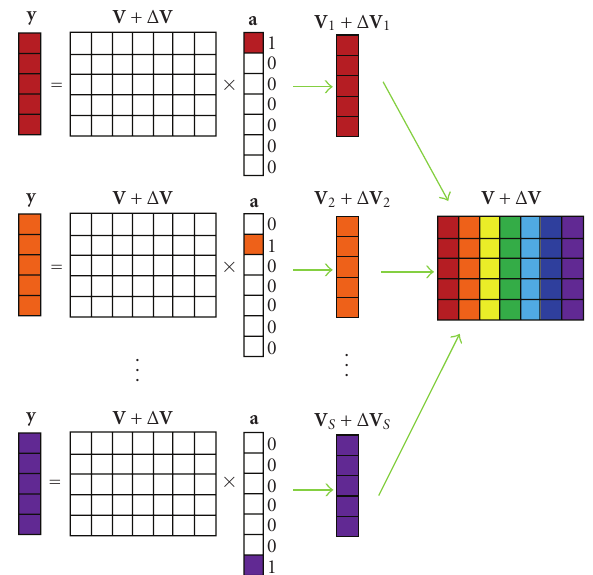
Figure 16: Illustration of the direct training approach to deal with the circuit imperfections.